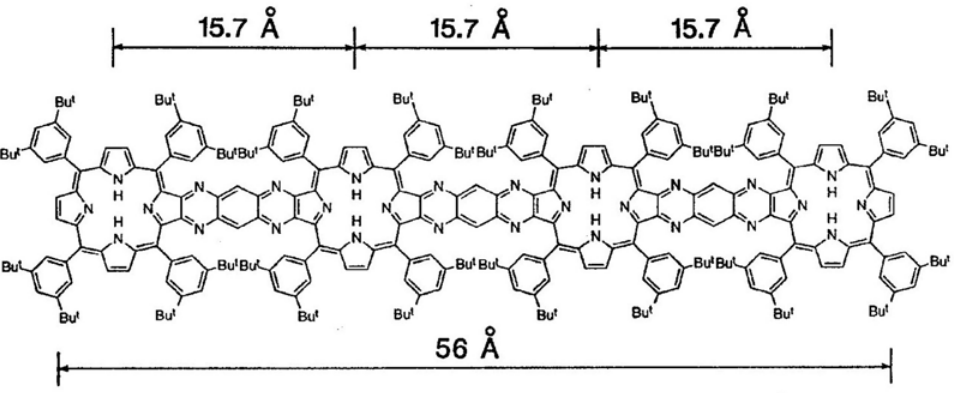
Figure 12. An anthracene-conjugated tetrakisporphyrin with tert -butyl substituents, after [24], with permission from the Royal Society of Chemistry .